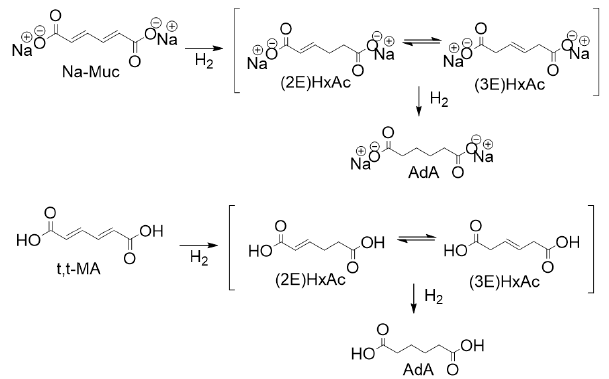
Figure 1. Reaction scheme of the hydrogenation of Na-Muc (top) and t,t-MA (bottom).